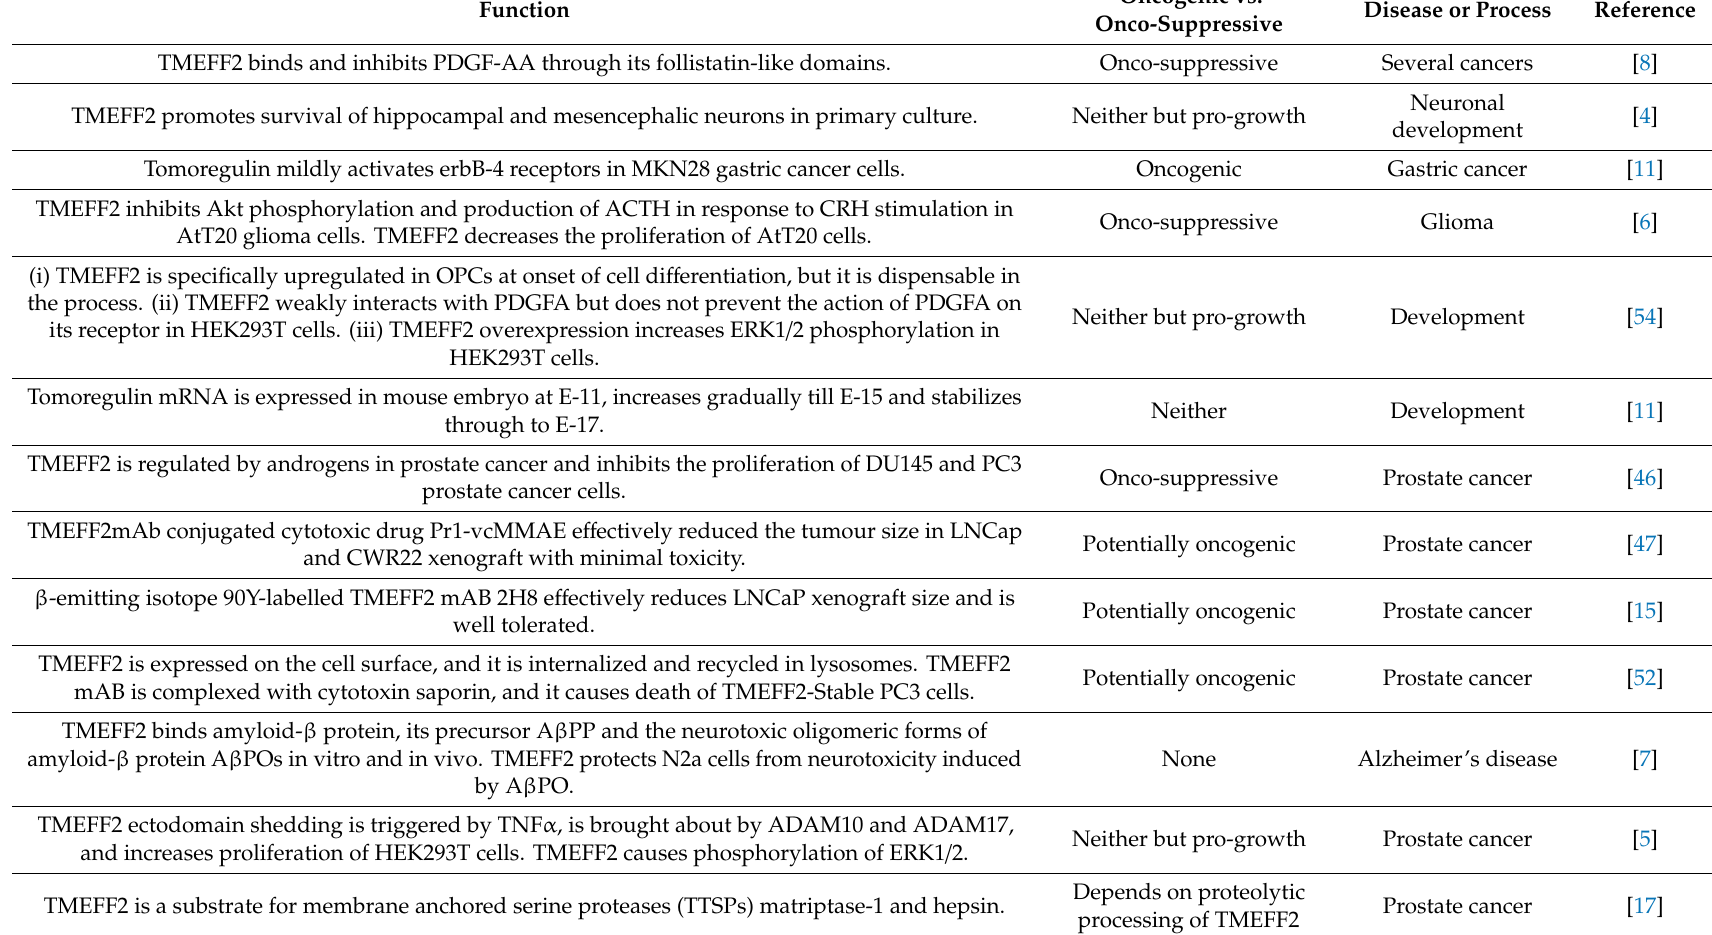
Table 3. Studies reporting TMEFF2